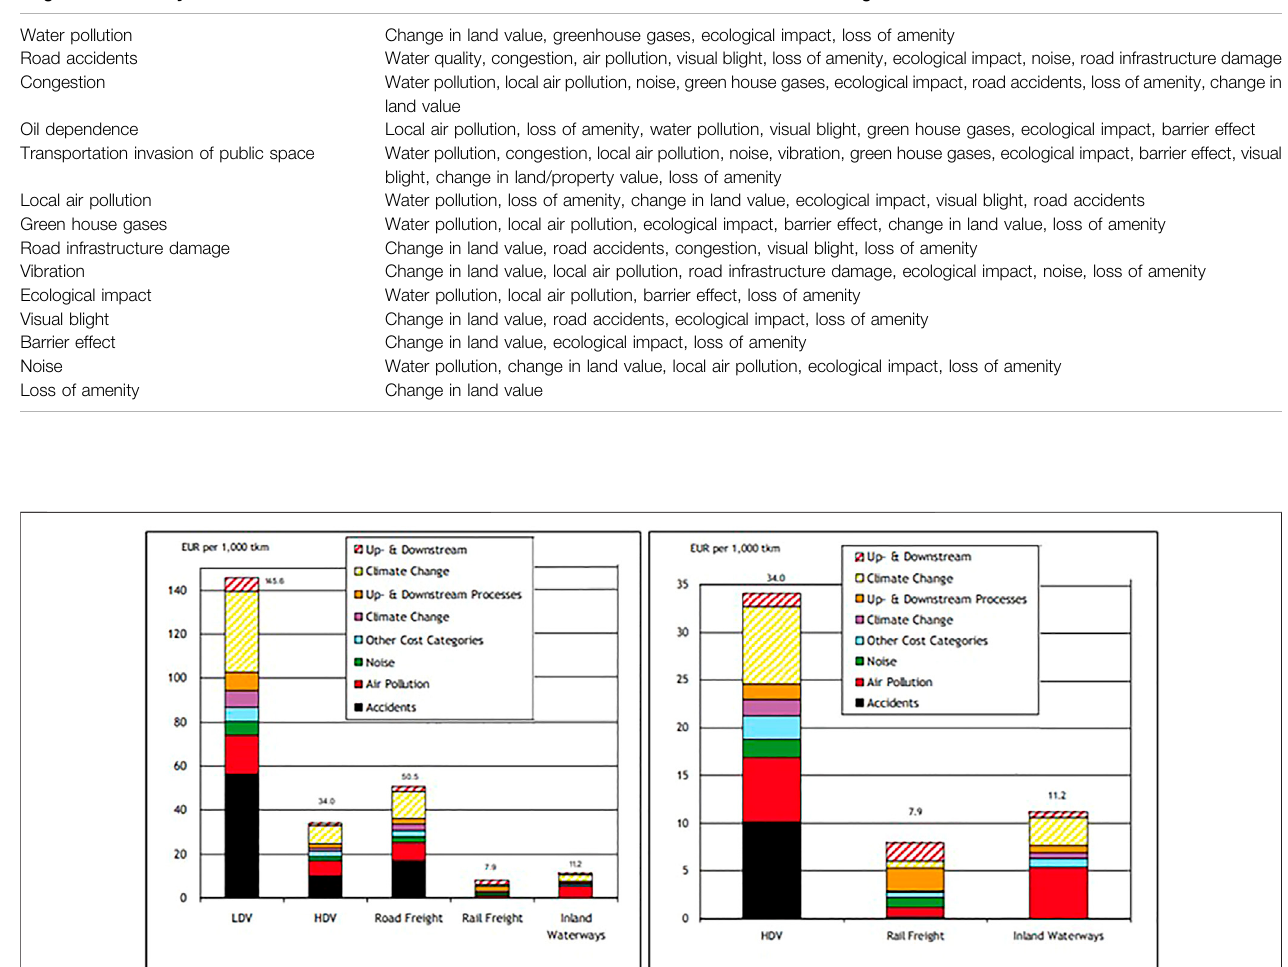
Frontiers in Built Environment |